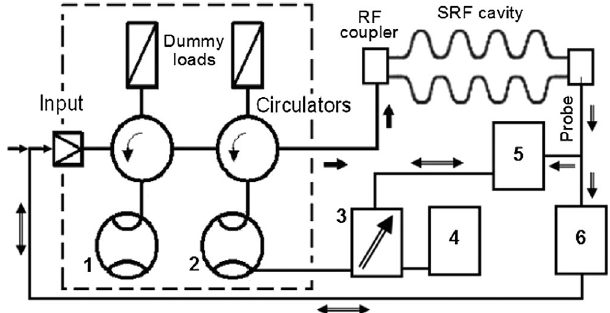
FIG. 12. Conceptual scheme of a 2-cascade magnetron single- channel transmitter allowing dynamic phase and power control at highest efficiency and the rates required for high-current accel- erators. 1: low power magnetron; 2: high-power magnetron; 3: low-power HV power supply controlled within the feedback loop; 4: main uncontrolled HV power supply; 5: current/voltage controller within the low level rf (LLRF) system for the controlled HV power supply; and 6: phase controller within the LLRF system.